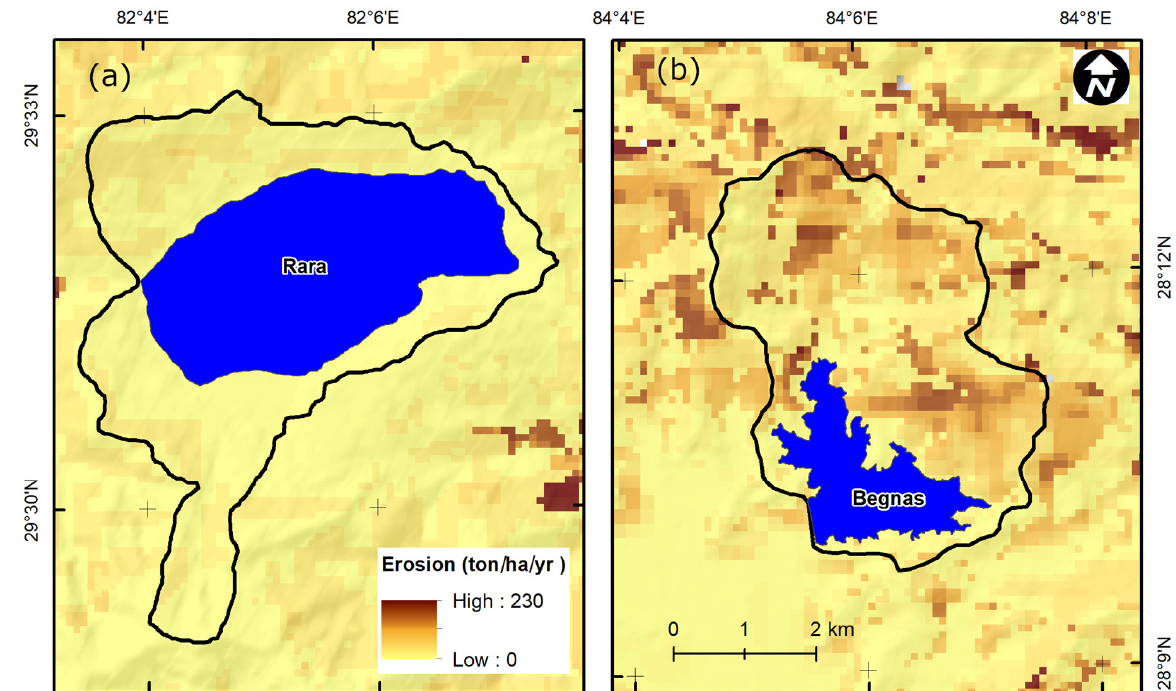
Figure 8. Soil erosion map of ( a ) Rara and ( b ) Begnas watersheds.